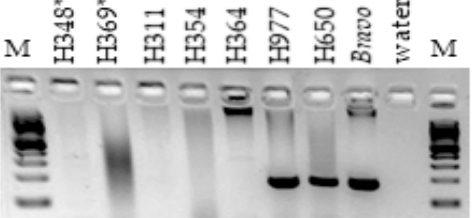
Figure 1. Discovery of homozygous deletion in horses with XY DSDs using PCR and DelIn1 primers; horses H348 and H369 denoted with an asterisk are the two related male pseudohermaphrodites where the deletion was initially discovered by aCGH; horses H311, H354 and H364 are cryptorchids; H977, H650 and Bravo are normal controls; M—100 bp ladder (NEB).